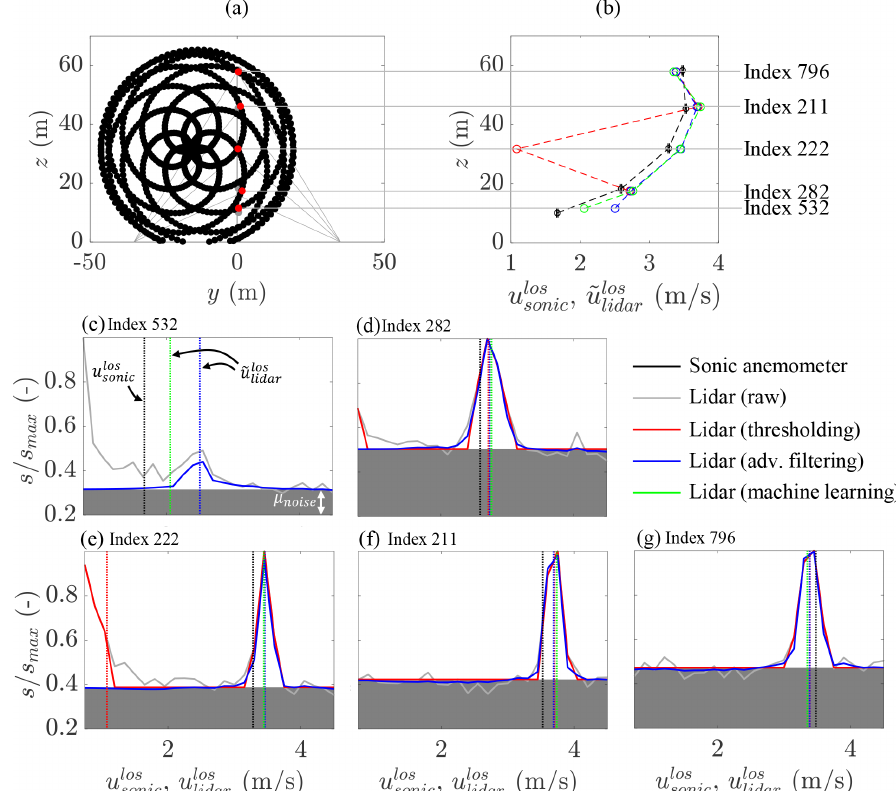
Figure 8. Comparison of lidar processing techniques for a single 2s inflow scan at 02:38:10 (local time) on 9 February 2017. In (a) , the instantaneous location of the lidar scan pattern (in black) is overlaid on the met tower (in gray) with the scan location closest to each respective sonic anemometer highlighted (in red). In (b) , the sonic line-of-sight velocity, u los , and lidar spectral median line-of-sight velocity, ˜ u los , sonic lidar are plotted vs. height, with the sonic anemometer data temporally interpolated to the same instant as the lidar passing. The uncertainty bands indicate the sonic anemometer instrument’s quoted uncertainty. Panels (c) – (g) show the individual scaled lidar spectra, s/s max , where s max = 2 16 − 1, for each of the index locations in (a) and (b) , with solid lines ( − ) indicating spectral magnitude and vertical dashed lines (–) indicating the line-of-sight velocity estimates. Panels (c) – (g) also show the raw lidar spectra, which have no corresponding entries in (b) since the raw data precede the MFE process. Note that the maximum value of panels (c) – (g) is always unity because the authors used the scaled version of the SpinnerLidar output; see Branlard et al. (2013) for